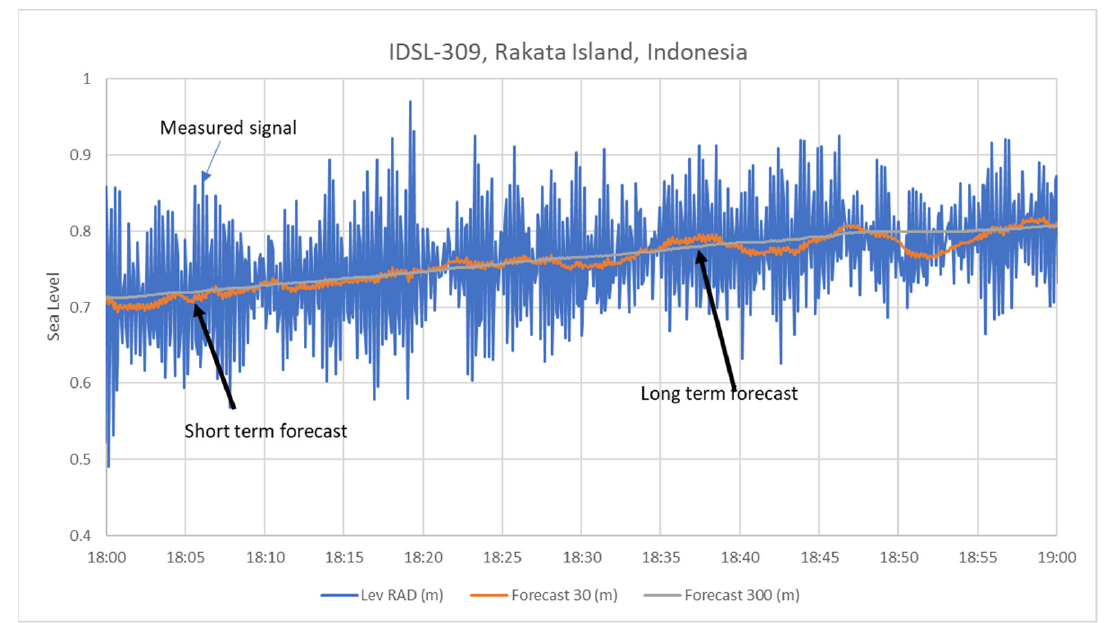
Figure 2. Sea level signals and computer parameters for short time period on the IDSL-309 installed on the Rakata Island, Indonesia.